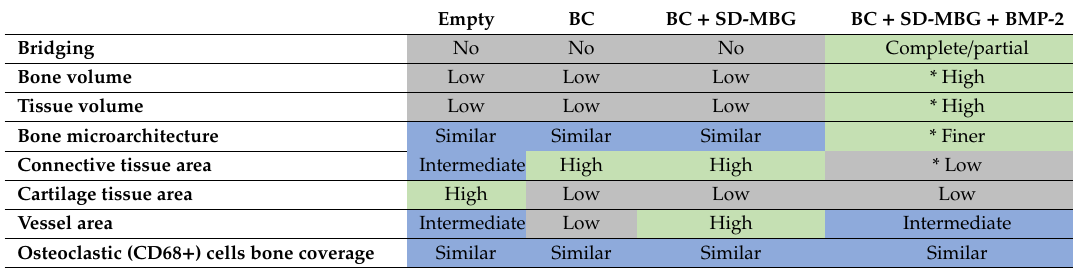
Table 3. Tabular summary of the in vivo bone healing analysis. The color coding is based on the values obtained in the di ff erent analysis. Grey: absent bridging / low values, blue: intermediate values / similar outcomes between groups, green observed bridging / finer callus and high